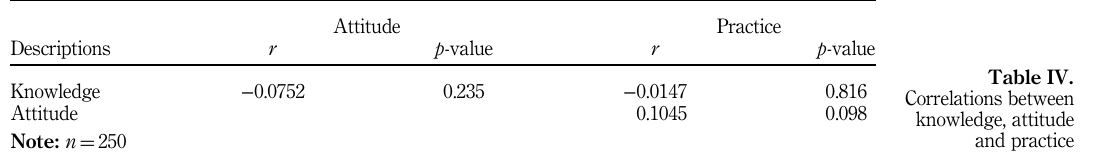
Table IV. Correlations